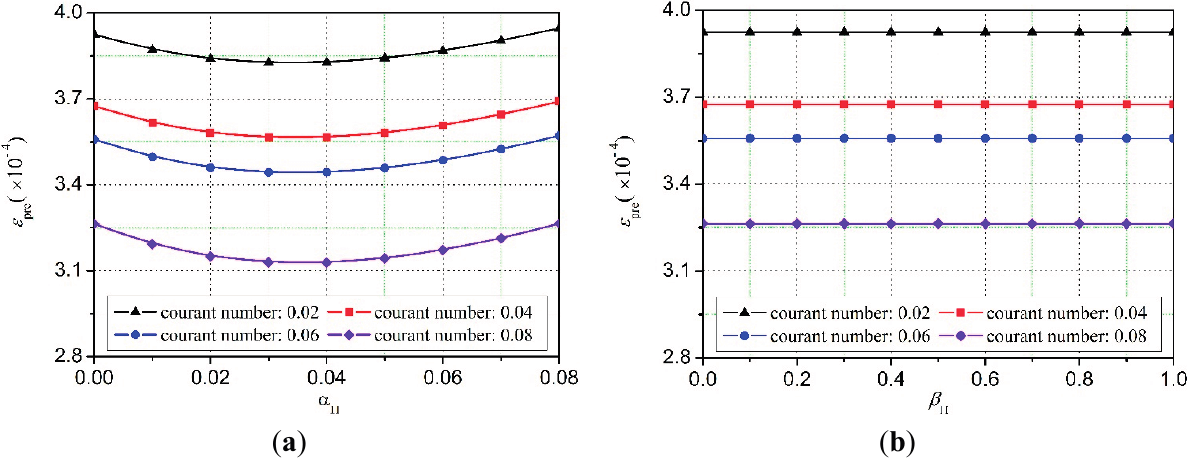
Figure 7. Numerical errors of sound pressure for sound interference models with different Courant numbers. The particle spacing Δ x is 0.04 m and the smoothing kernel function is cubic spline. ( a ) Effects of α П on the simulation results at β П = 0.5; ( b ) effects of β П on the simulation results at α П =